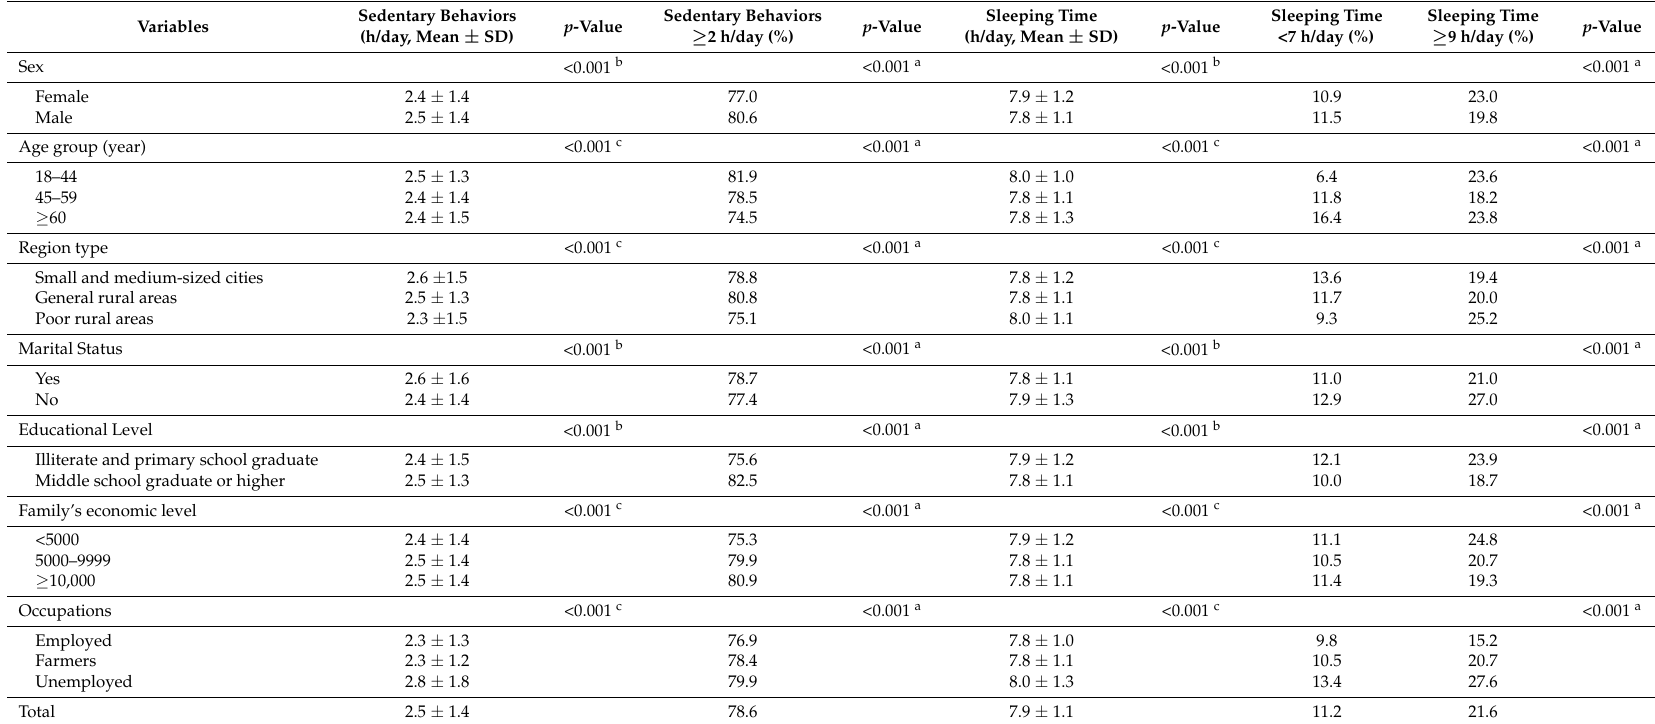
Table 6. Time of sedentary behaviors and sleeping among rural Chinese